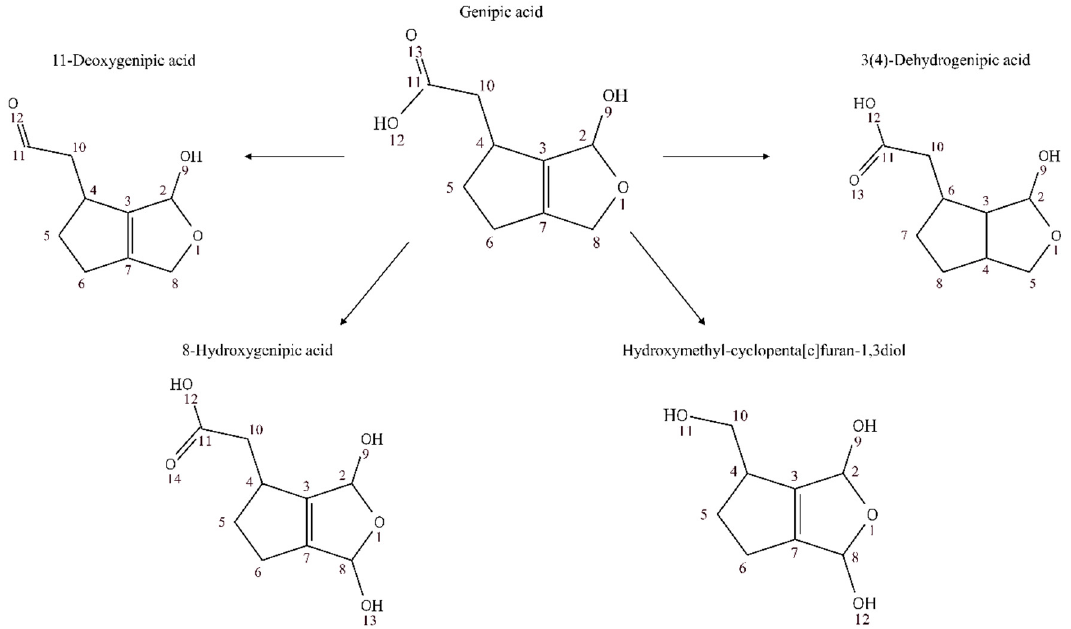
Figure 7. Proposed derivative forms of genipic acid in human urine samples after genipap juice intake.